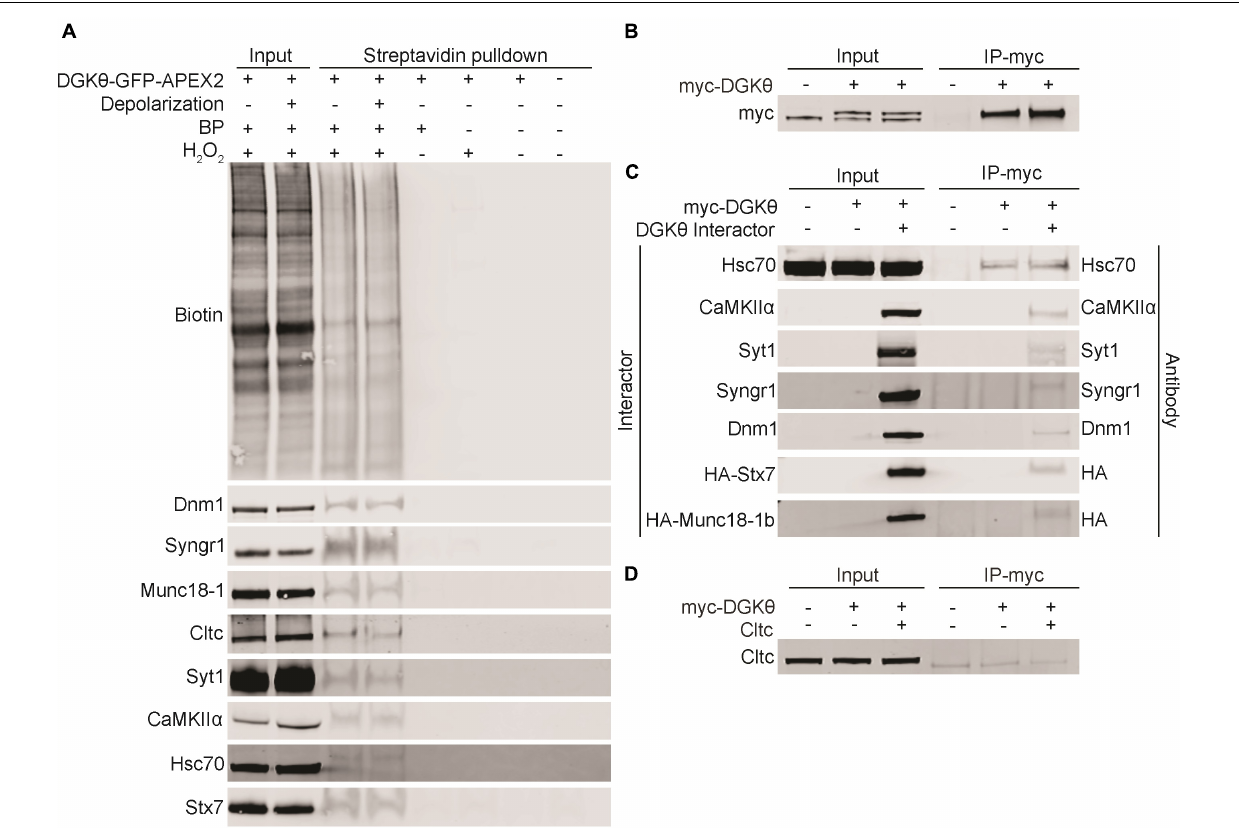
Frontiers in Synaptic Neuroscience |